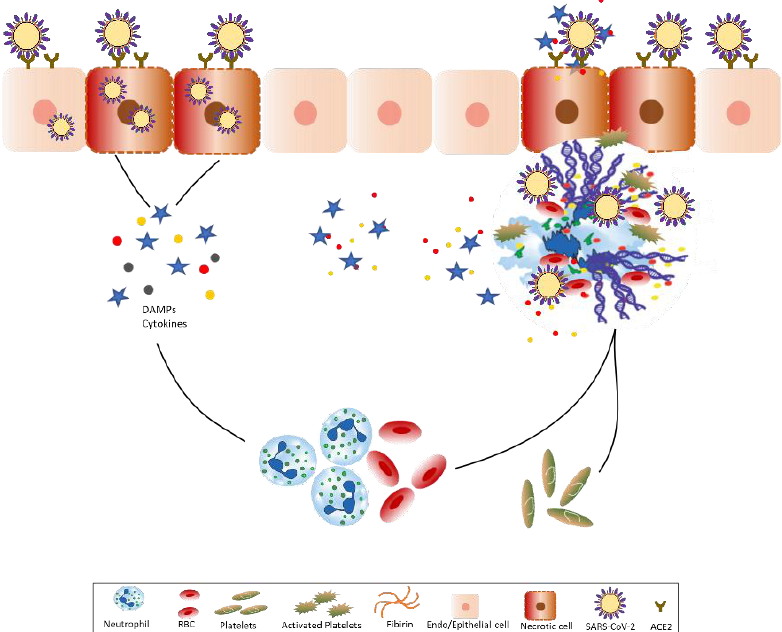
Figure 1. Neutrophils and neutrophil extracellular traps drive necroinflammation in COVID-19.